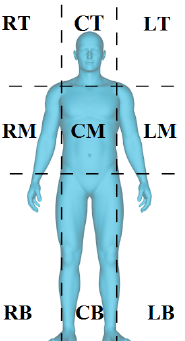
Fig. 6: Regions of interest: RT = Top , LT = } Center, Middle { tom , CB = }